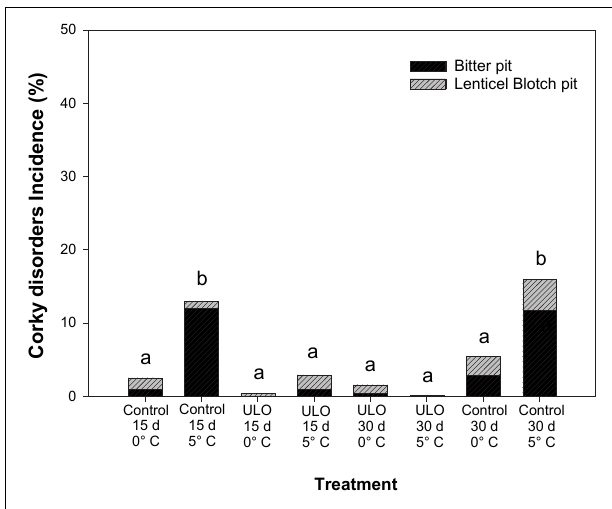
FIGURE 3 | Effect of ULO condition treatments for 15 and 30 days at 0 or 5 ◦ C on incidence of bitter pit and lenticel blotch pit after 9 days of ripening at 20 ◦ C in ‘Fuji’ apples previously stored for 90 days at 0 ◦ C. Values are means, n:4 replicates. Means with different letters are significantly different based